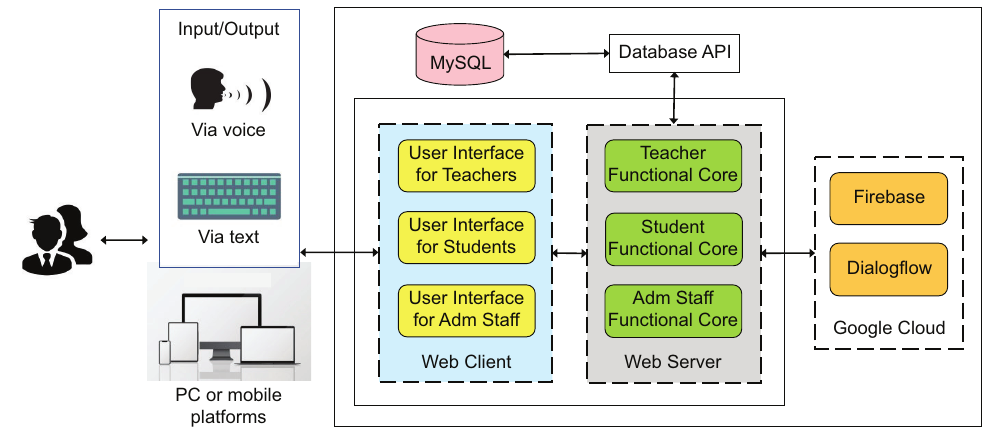
Figure 6. Tools and technologies used to implement the main components of our chatbot.